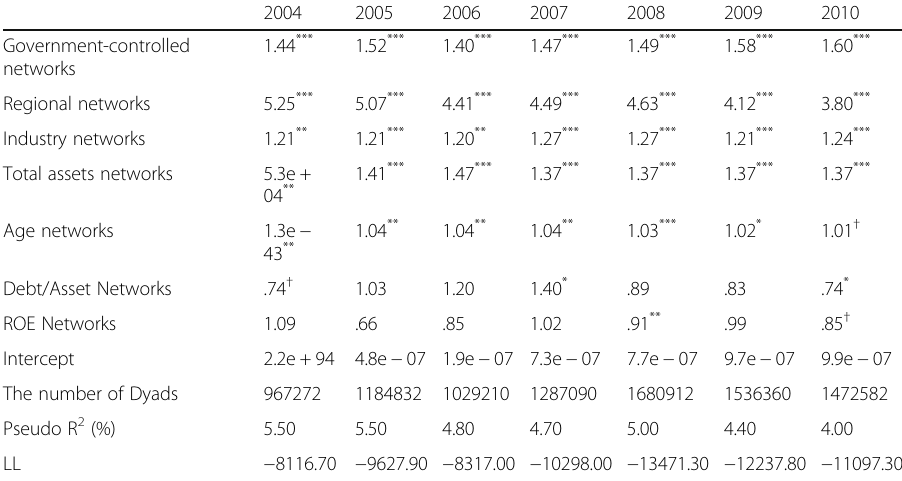
Table 5 Different administrative levels of government-controlled networks and interlocking direct- orate networks: 2004 – 2010, QAP logistic regression